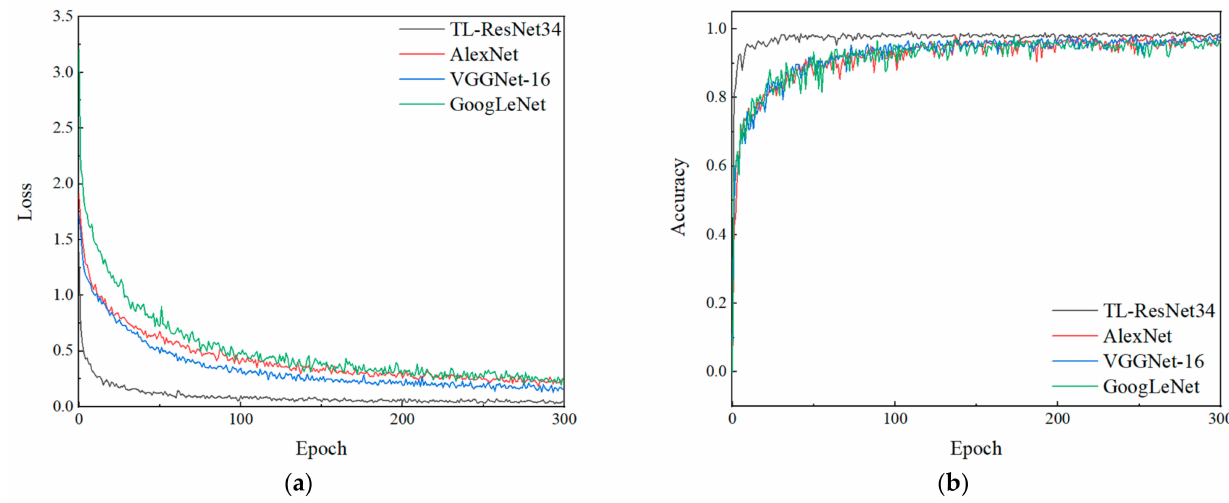
Figure 7. Convergence comparison: ( a ) Loss value; ( b ) Accuracy